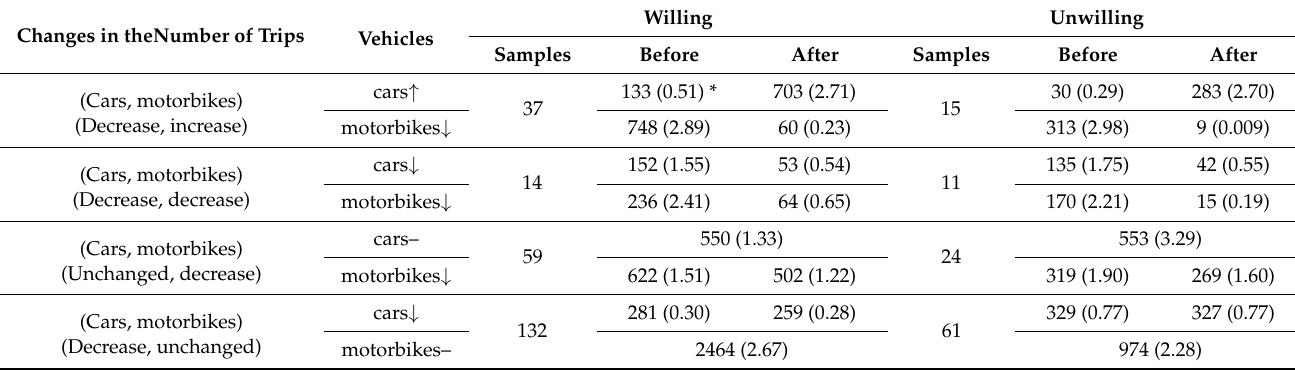
Table 7. Analysis of vehicle changes before and after prohibition, and the willingness and unwillingness of motorbike drivers to use alcohol